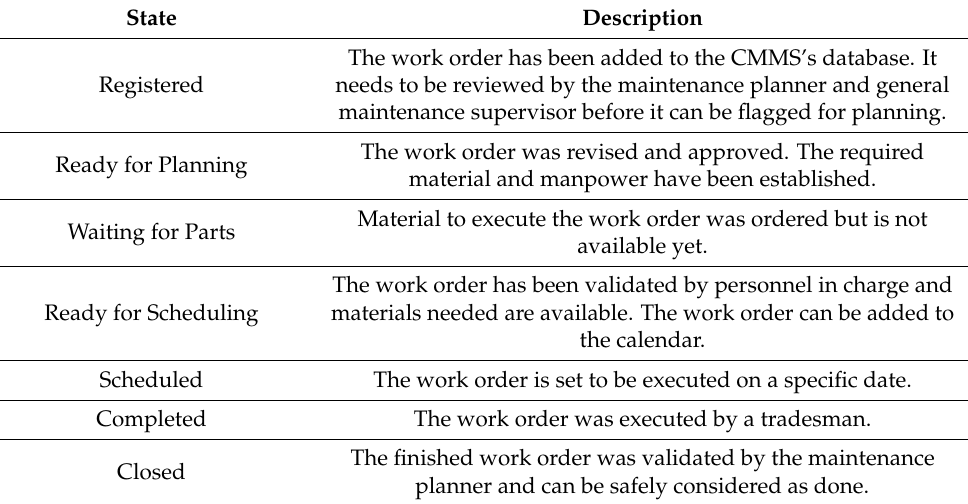
Table 3. Work order life cycle states and